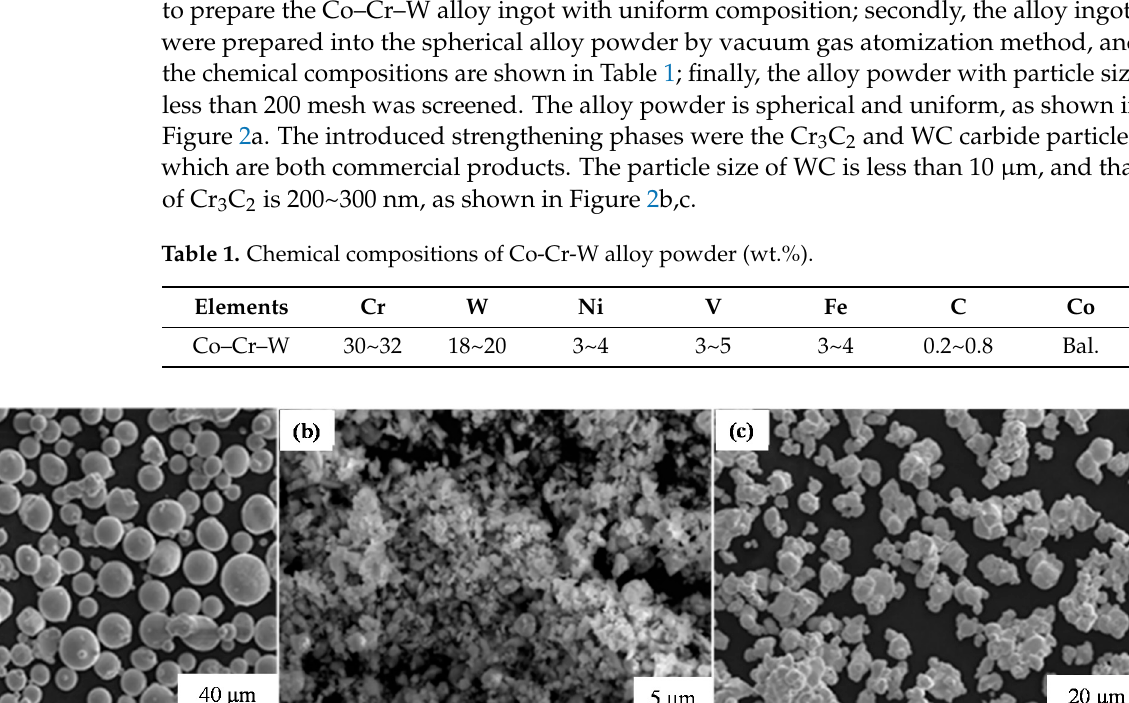
Figure 1. Schematic of the microstructure of the alloy prepared by introducing the reinforced carbides [14].